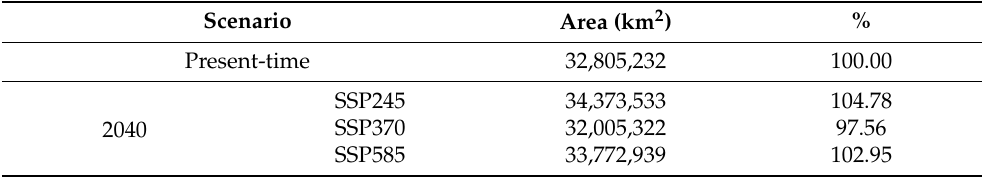
Table 2. Evolution of the estimated potential distribution area of Sympetrum flaveolum in absolute and relative values (Present—2100).